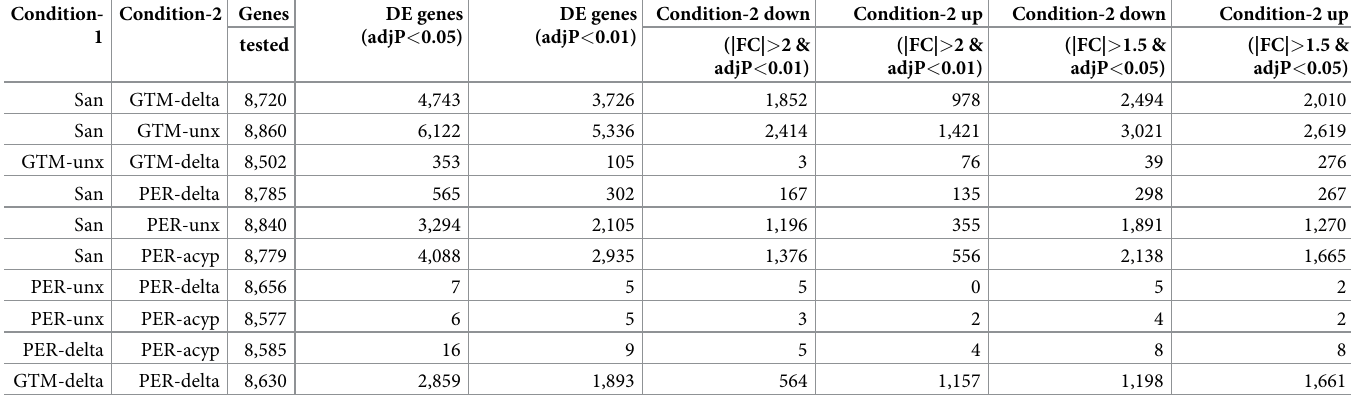
Table 1. Summary of results of differential gene expression analyses. DE = differentially expressed, FC = Fold change and adjP = P-value adjusted for multiple testing by the method of Benjamini and Hochberg 1995 [51]. Condition- Condition-2 1